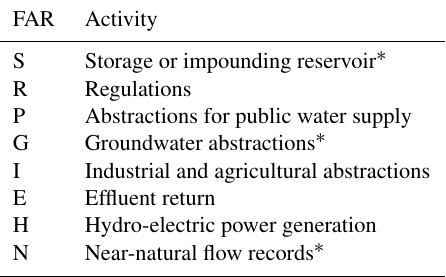
Table 1. FAR codes and their meaning.